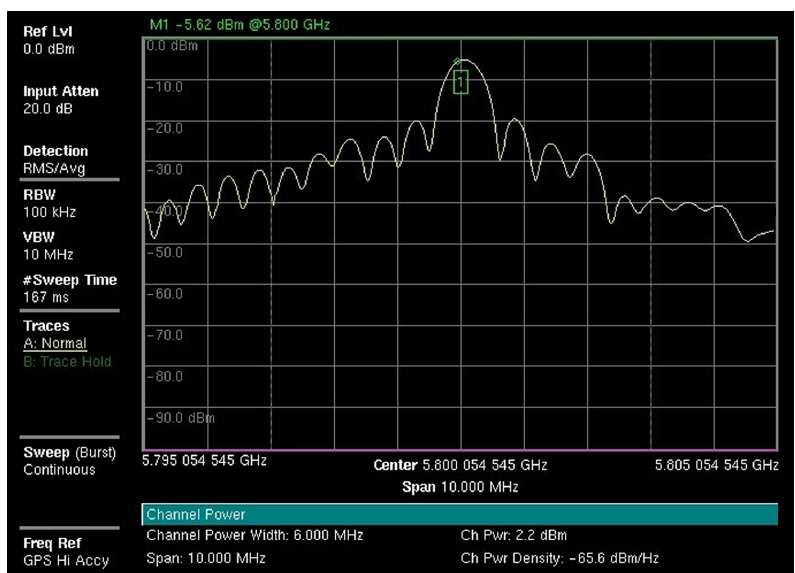
Figure 8. Radar signal spectrum and measured average power (Anritsu MS2720T).